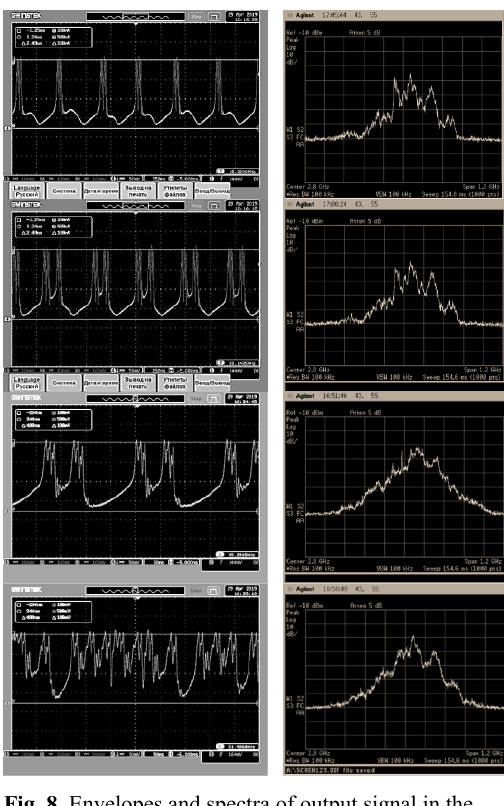
Fig. 8. Envelopes and spectra of output signal in the auto-transition mode with the introduction of asymmetry.